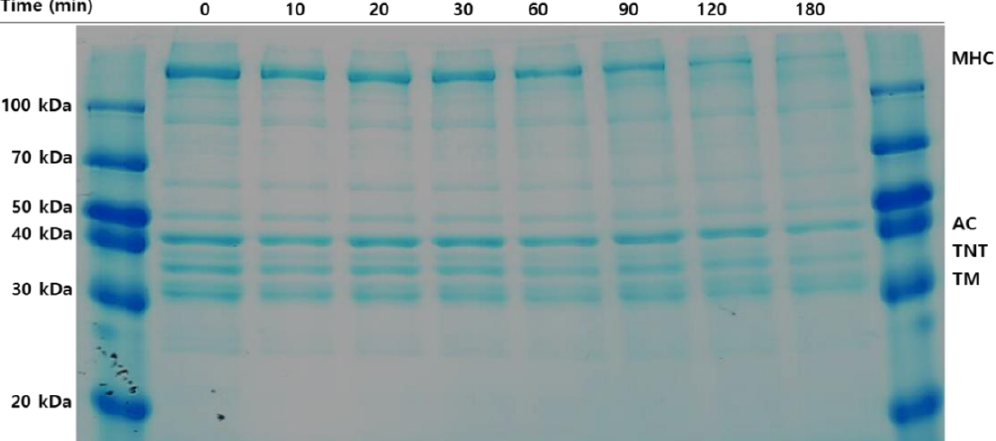
Figure 3. Autolytic pattern of olive flounder paste. Samples were incubated for 180 min at 60 °C. Myosin heavy chain (MHC); actin (AC); troponin-T (TNT); tropomyosin (TM).